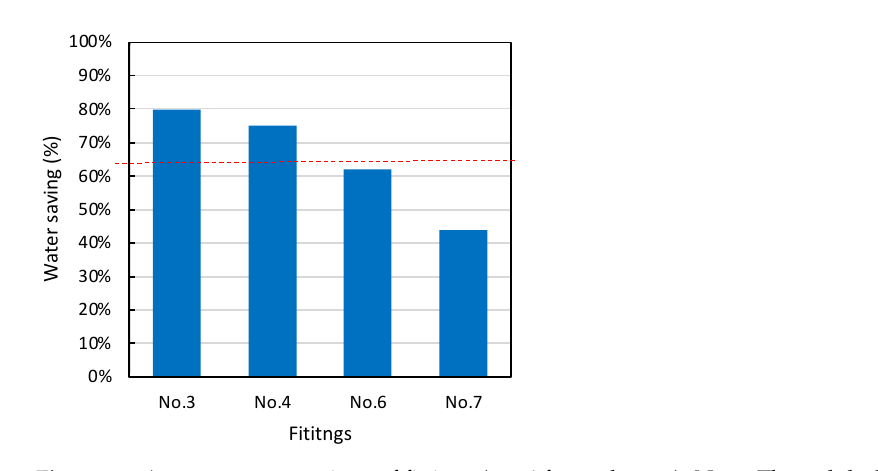
Figure 11. Average water savings of four types of fittings at different faucet openings ( n = 4). To verify the effectiveness of water-saving fittings, the water and tariff savings for a typical house of an emirate national were calculated. First, the number of toilets and fit- tings in the home were counted, and the total cost of installing dual-flush toilets and wa- ter-saving fittings was calculated (Table 4). The payback period (in months) was then cal- culated, using two water consumption data measurements: 350 LPCD, as specified in the Guide to Water Supply Regulation, and the actual water consumption rate of 225 LPDC, as noted in the November 2020 water bill (Table 5). These values were substantially lower than the minimum per capita water consump- tion of 582 LPCD in Figure 8 because the Guide’s water consumption values reflected the Abu Dhabi government’s strategy to minimize water consumption, and because adults in the home went out for work during the day in the same way as in 2018 (Figure 9). The payback periods for dual-flush toilets and water-saving faucets were computed using the actual water tariff, with and without government subsidies. Table 4 shows that, for 225 LPCD, the payback period with subsidy was calculated to be 33.3 months (7.2 months without subsidy).